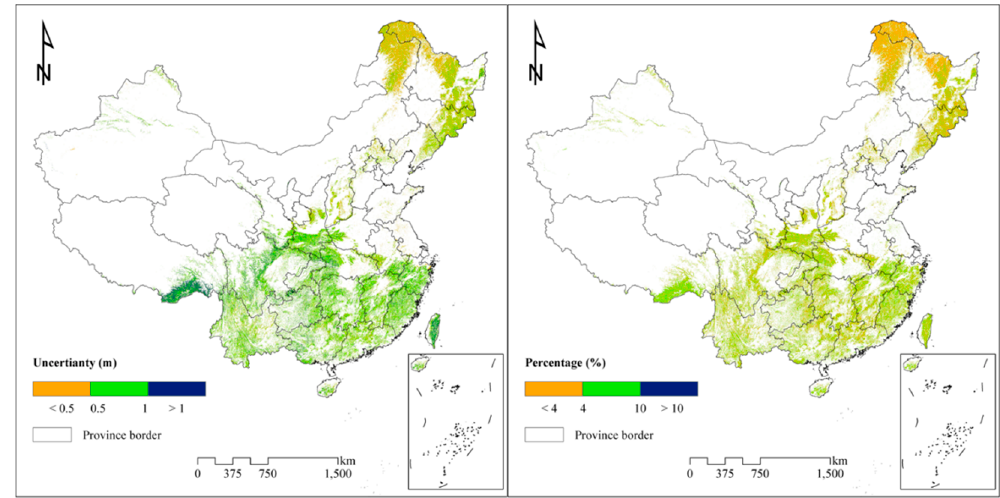
Figure 11. Uncertainty of forest heights in China ( left ) and the relative error pattern ( right ).